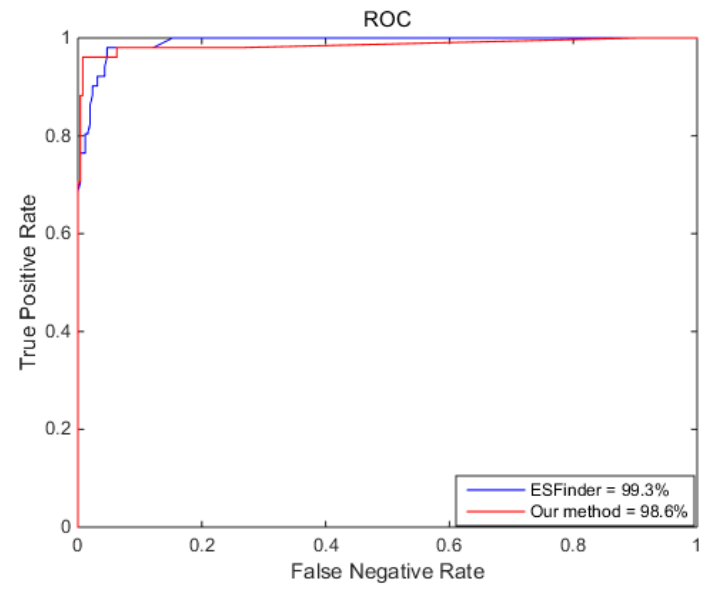
Figure 5. The ROCs of different methods.